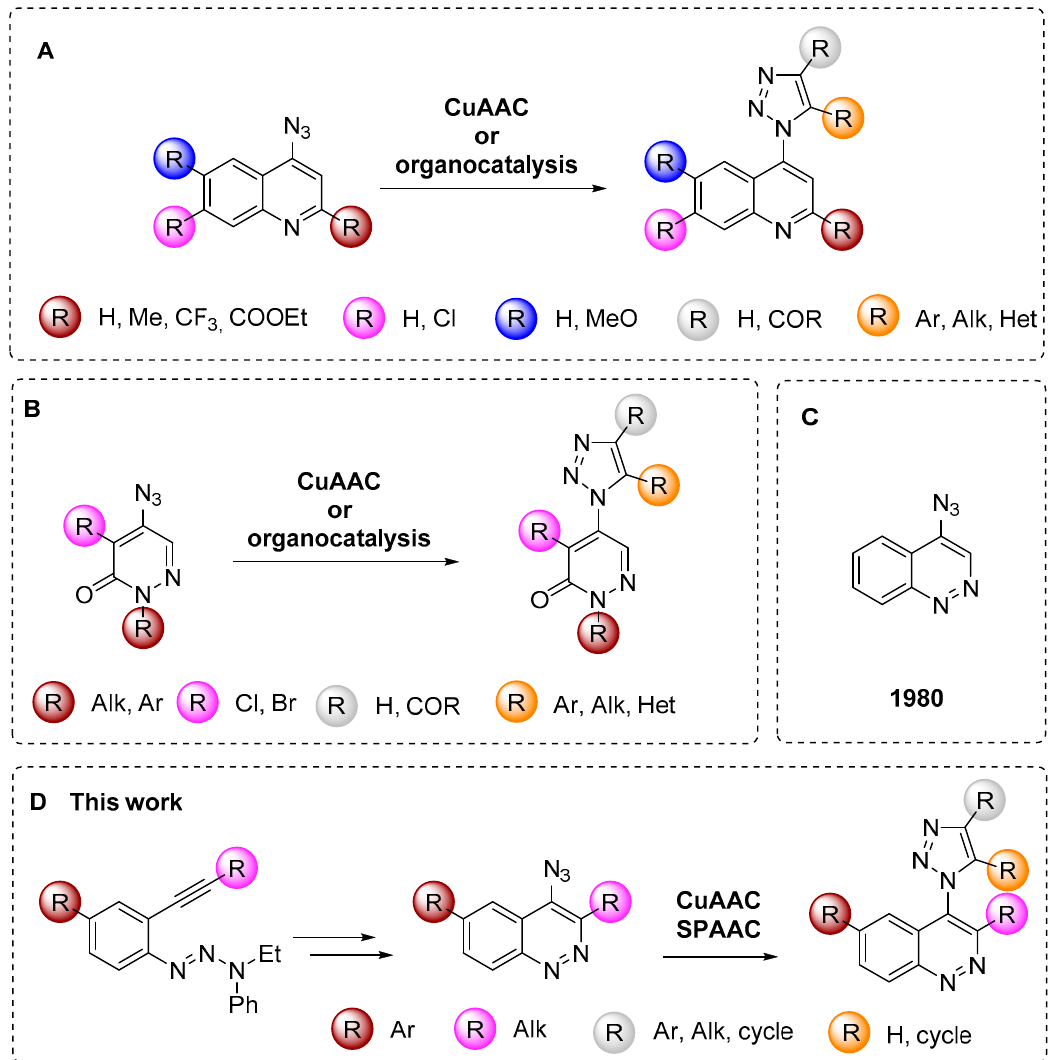
Figure 2. Known examples of azidoquinolines, azidopyridazines and the corresponding triazoles compared to azidocinnoline derivatives ( A – D.